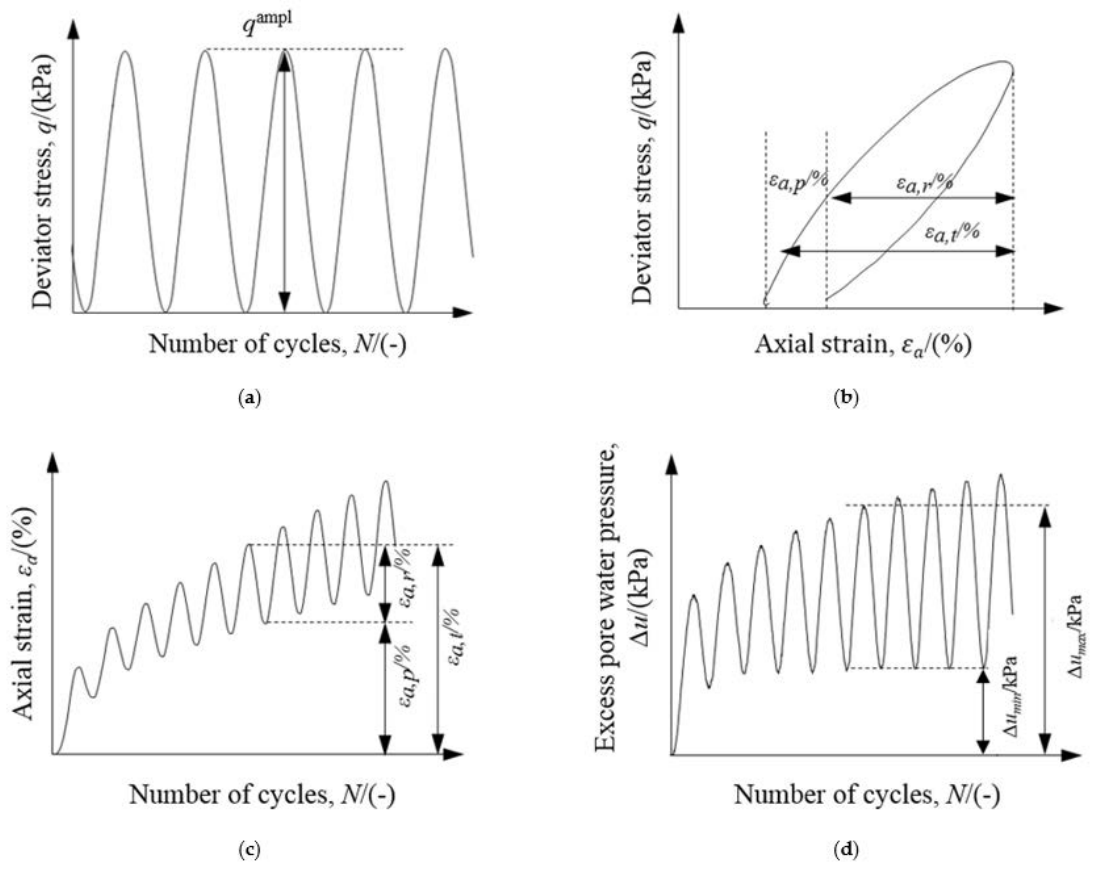
Figure 4. Sketch of cyclic triaxial test results under constant confining pressure: ( a ) q - n ; ( b ) q - ε a ; ( c ) ε a - n ; ( d ) ∆ u - n